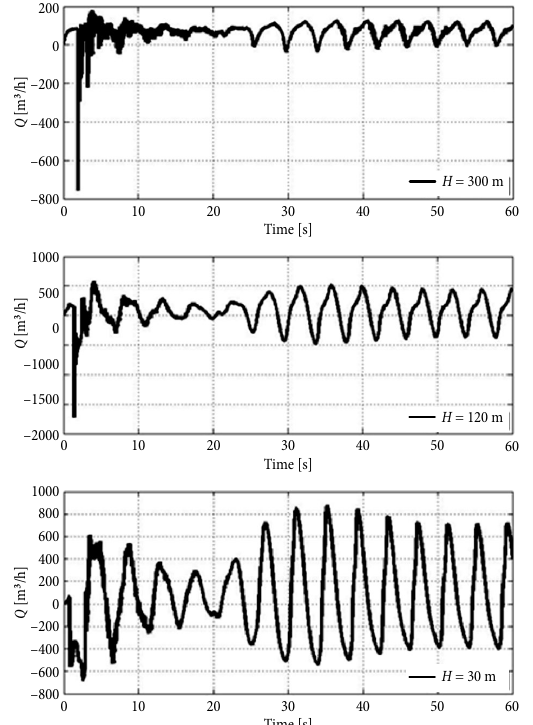
Fig. 12. Spectrum of the amplitude of pressure in the 1st, 5th, 10th, 13th and 16th stages of the centrifugal pump, when = 0.25